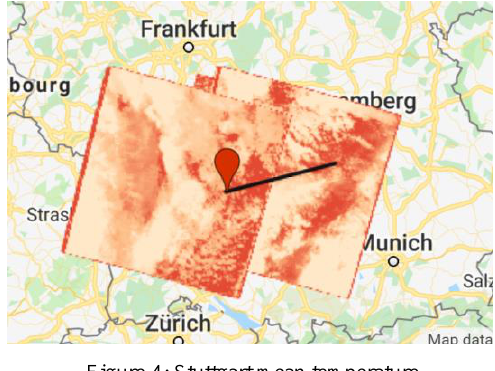
Figure 4: Stuttgart mean temperature